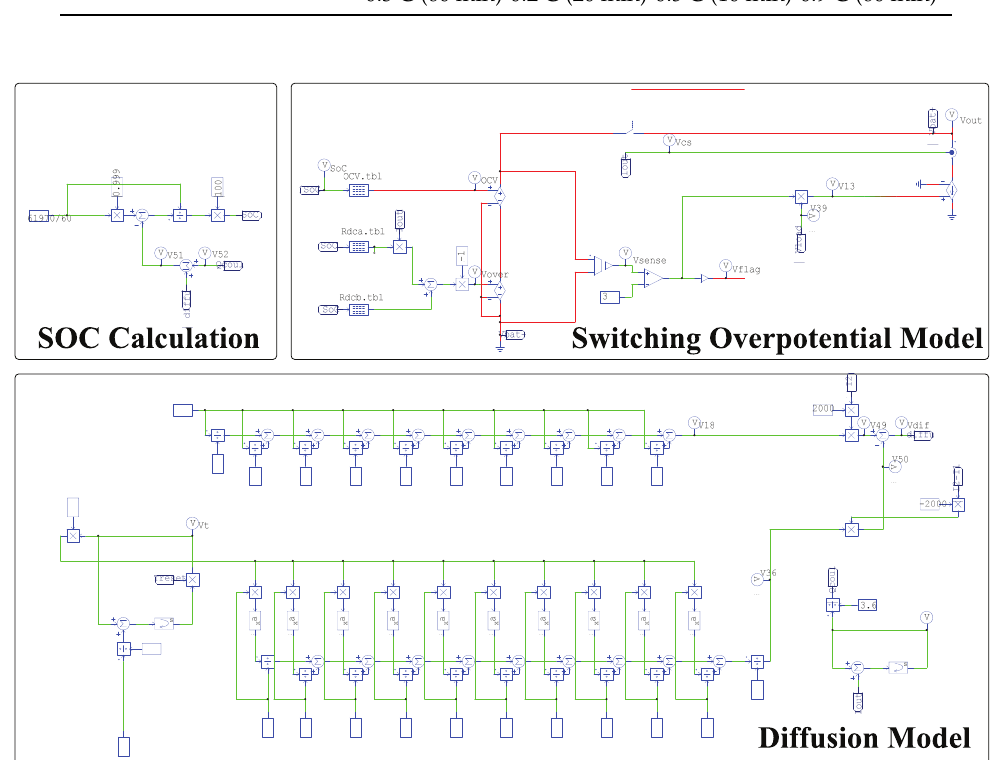
Figure 8. PSIM environment for battery